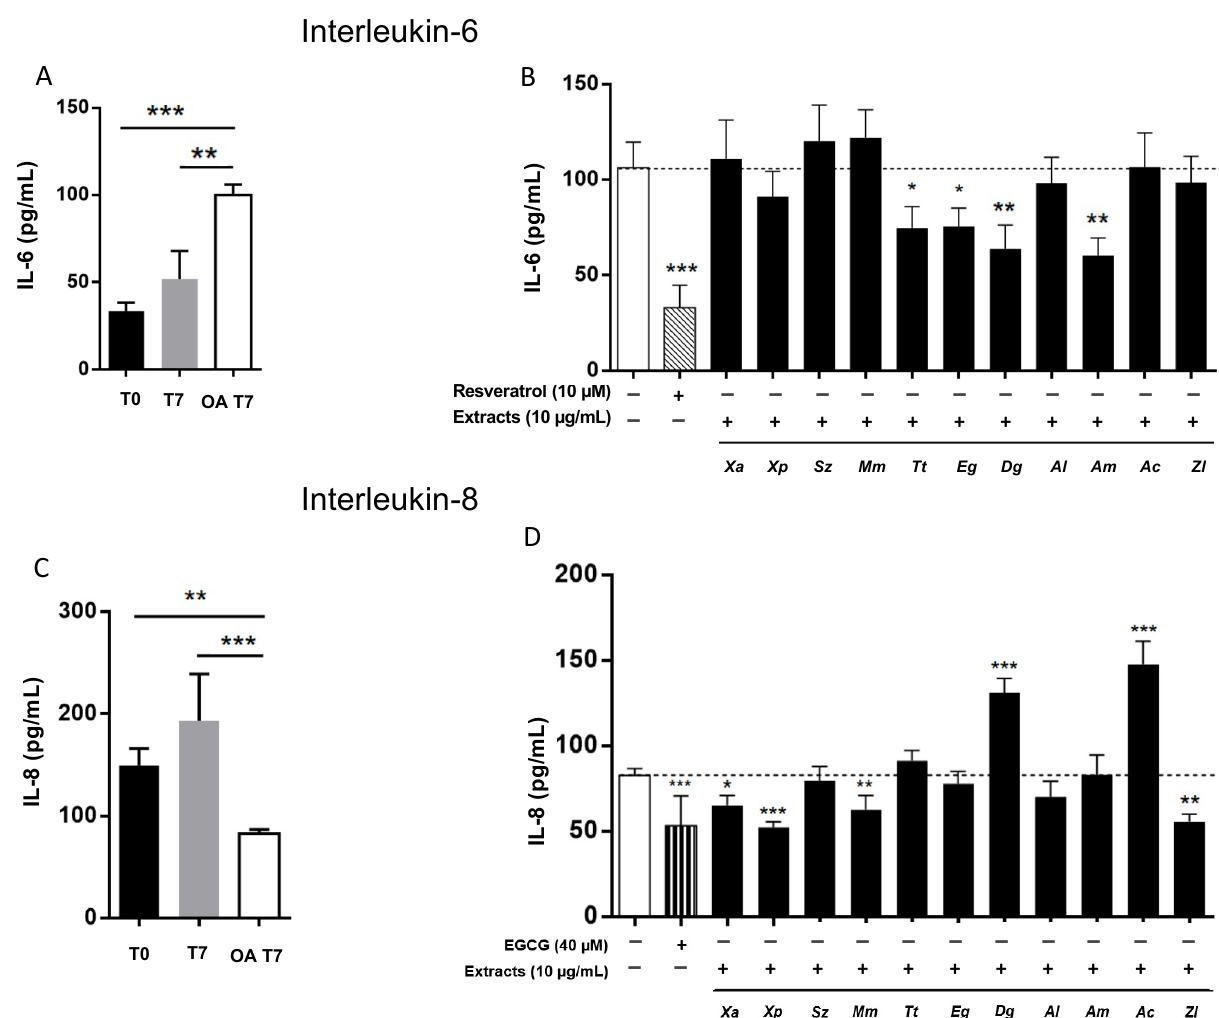
Figure 4. Effects of spice extracts on interleukin-6 (IL-6) and interleukin-8 (IL-8) release by differentiated SW 872 cells. ( A ) Basal IL-6 content was determined at T0 and T7 (1 and 7 days after seeding, respectively) and at OA T7 (after 7-day differentiation with 100 µ M oleic acid (OA)). ( B ) OA-differentiated cells were treated with 10 µ g/mL spice extracts or the positive controls (10 µ M resveratrol or 40 µ M epigallocatechin gallate (EGCG)). ( C ) Basal IL-8 content was determined at T0 and T7 (1 and 7 days after seeding, respectively) and at OA T7 (after 7-day differentiation with 100 µ M OA). ( D ) OA- differentiated cells were treated with 10 µ g/mL spice extracts or the positive controls (10 µ M resveratrol or 40 µ M EGCG). IL-6 and IL-8 content in the culture medium was determined after 24 h incubation. One experiment ( n = 3) is shown as representative of 3 separate experiments, each in triplicate. Results are shown as mean ± SD. Data are expressed as pg/mL. * p < 0.05, ** p < 0.01, *** p < 0.001 (one-way ANOVA multiple comparison). Xa : Xylopia aethiopica ; Xp : Xylopia parviflora ; Sz : Scorodophloeus zenkeri ; Mm : Monodora myristica ; Tt : Tetrapleura tetraptera ; Eg : Echinops giganteus ; Dg : Dichrostachys glomerata